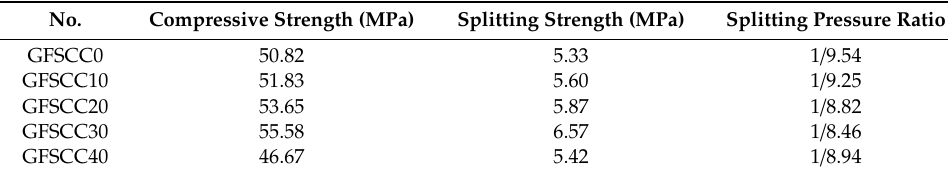
Table 10. The splitting pressure